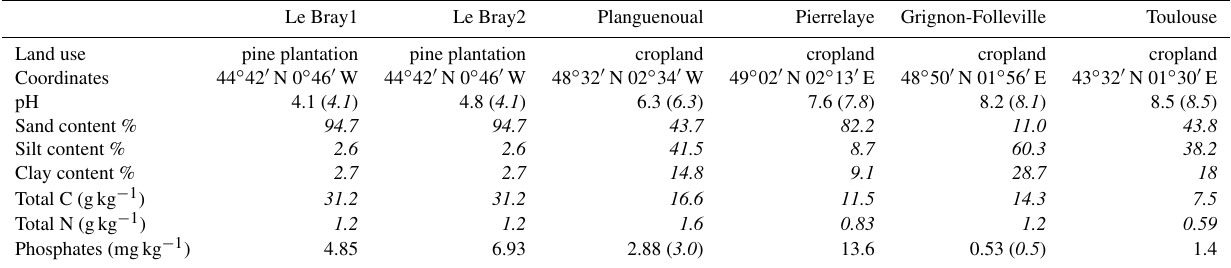
Table 1. Main characteristics of the soils investigated in this study. Numbers in italics indicate literature data (Achat et al., 2014). Le Bray1 Le Bray2 Planguenoual Pierrelaye Grignon-Folleville Toulouse pine plantation cropland cropland